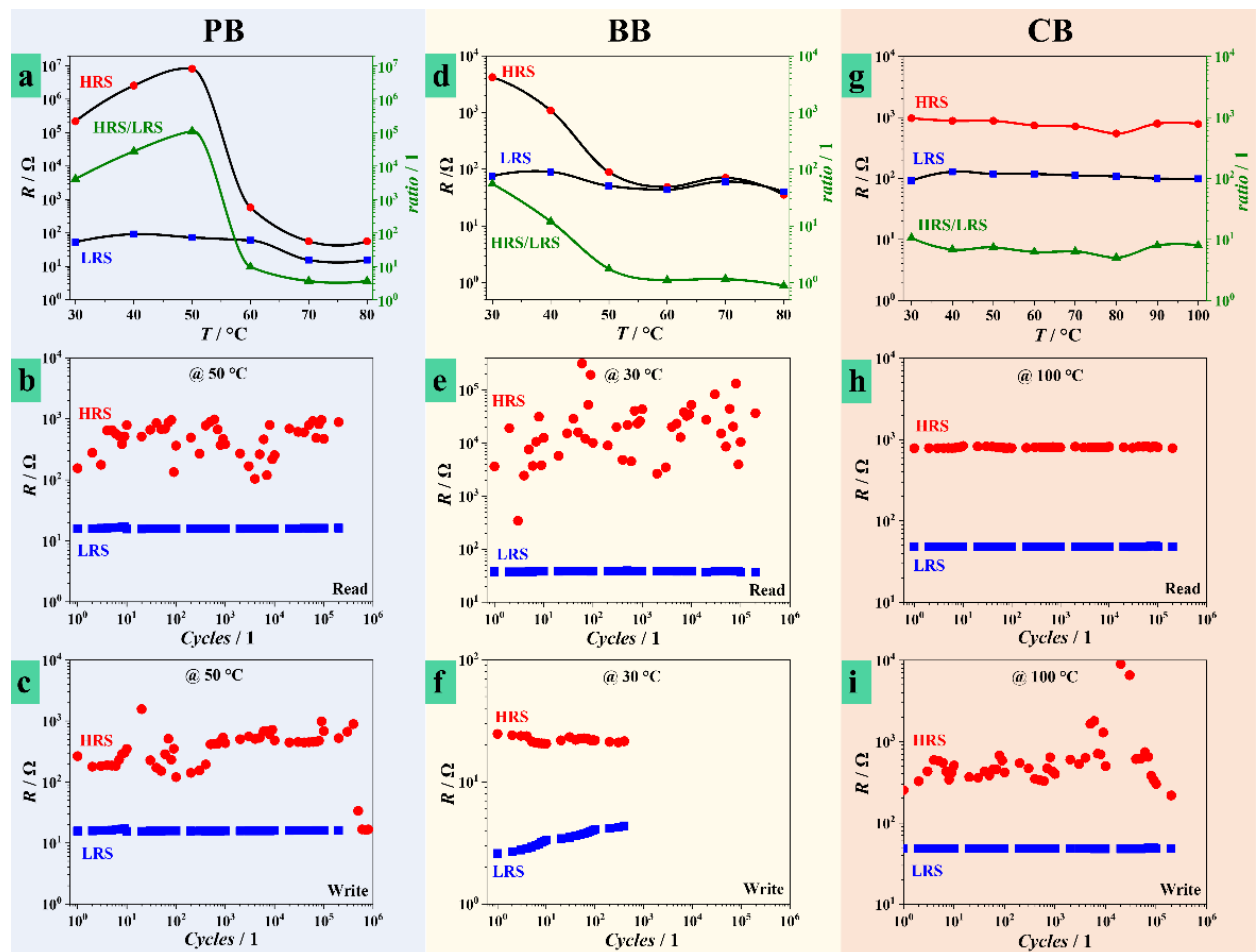
Figure 4. Heat treatment effects on anodic memristive devices, temperature mapped as high resistance states (HRS)/low resistance states (LRS) ratios with retention and endurance (read/write) tests performed at selected optimum temperatures for memristors grown in PB ( a – c ), BB ( d – f ), and CB ( g – i ) electrolytes.